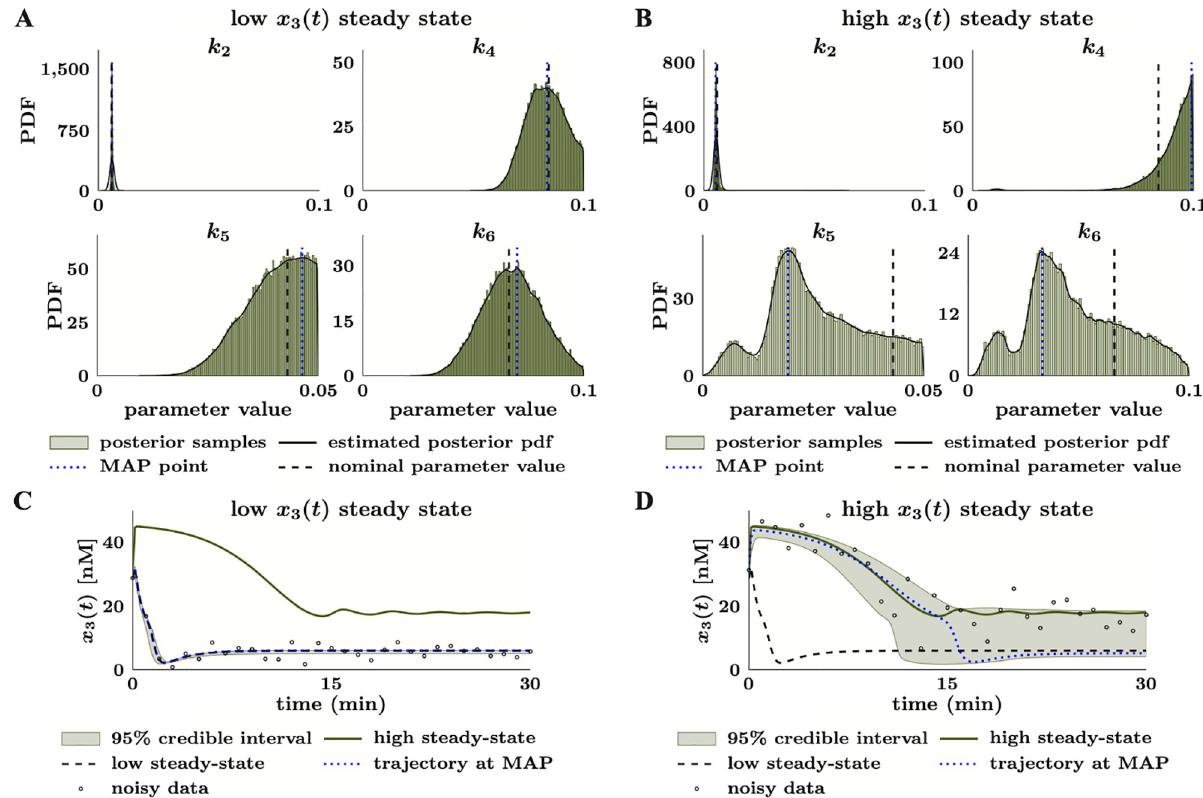
Fig 5. Varying levels of uncertainty in the parameters associated with the MAPK model impact steady state prediction. ( A ) Marginal posterior distributions of the model parameters for parameter estimation from noisy data of the low steady state. Posterior distributions are visualized by fitting a kernel density estimator to 325,200 (150 walkers with 2,660 steps each) MCMC samples obtained using CIUKF-MCMC with the affine invariant ensemble sampler (AIES) for MCMC after discarding the first 840 samples per walker as burn-in. ( B ) Marginal posterior distributions of the model parameters for parameter estimation from noisy data of the high steady state reveal larger uncertainty in the model parameters when compared to the low steady state. We visualize distributions by fitting a kernel density estimator to 347,700 (150 walkers with 2,644 steps each) MCMC samples obtained using CIUKF-MCMC with the affine invariant ensemble sampler (AIES) for MCMC after discarding the first 856 samples per walker as burn-in. ( C ) Posterior distribution of the trajectory of x 3 ( t ) with initial conditions that yield the low steady state highlights low uncertainty in the predicted dynamics. The true trajectory (dashed black line) shows the dynamics with the nominal parameters, the dotted blue line shows the trajectory evaluated at the MAP point, and the empty circles show the noisy data (covariance is 50% of the standard deviation of the true trajectory). The 95% credible interval shows the region between the 2.5th and 97.5th percentiles that contains 95% of 30,000 posterior trajectories. ( D ) Posterior distribution of the trajectory of x 3 ( t ) with initial conditions that yield the high steady state highlights the ambiguity between which steady state is reached. All lines and computations are the same as in panel ( A ), except simulations were run using an initial condition that results in the high steady